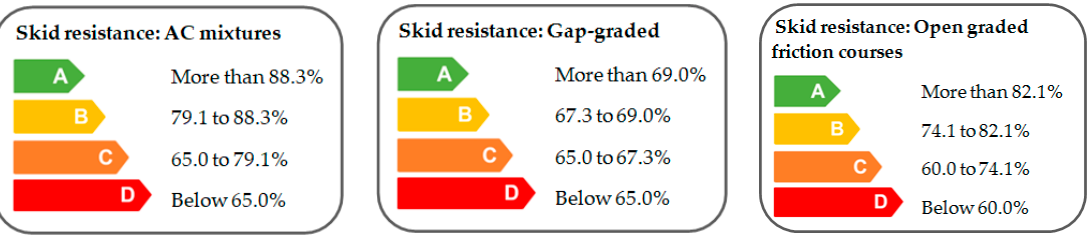
Figure 21. Macrotexture and skid resistance global label. Concerning the “splash and spray” effect, all the values were obtained during the monitoring stage. The test trailer measured the number and distribution of drops that crossed a reference plane at a given time. Even though it is well known that this effect is directly related to the loss of visibility, it is not considered in the European technical standards. Hence, the upper limit was established based on the monitoring experience [24]. As the obtained results did not follow a normal or log ‐ normal distribution, the boundary criterion was directly applied to the sorted values (see Figure 22). Figure 22. “Splash and spray” effect label. 3.3. Environmental Performance The current Spanish technical standard envisages the use of some sustainable technologies, but it does not clearly establish practical recommendations or limits because, unfortunately, there is not an extended use of such technologies to date. Thus, in this case, in order to define the limits, research investigations and industry recommendations were used.